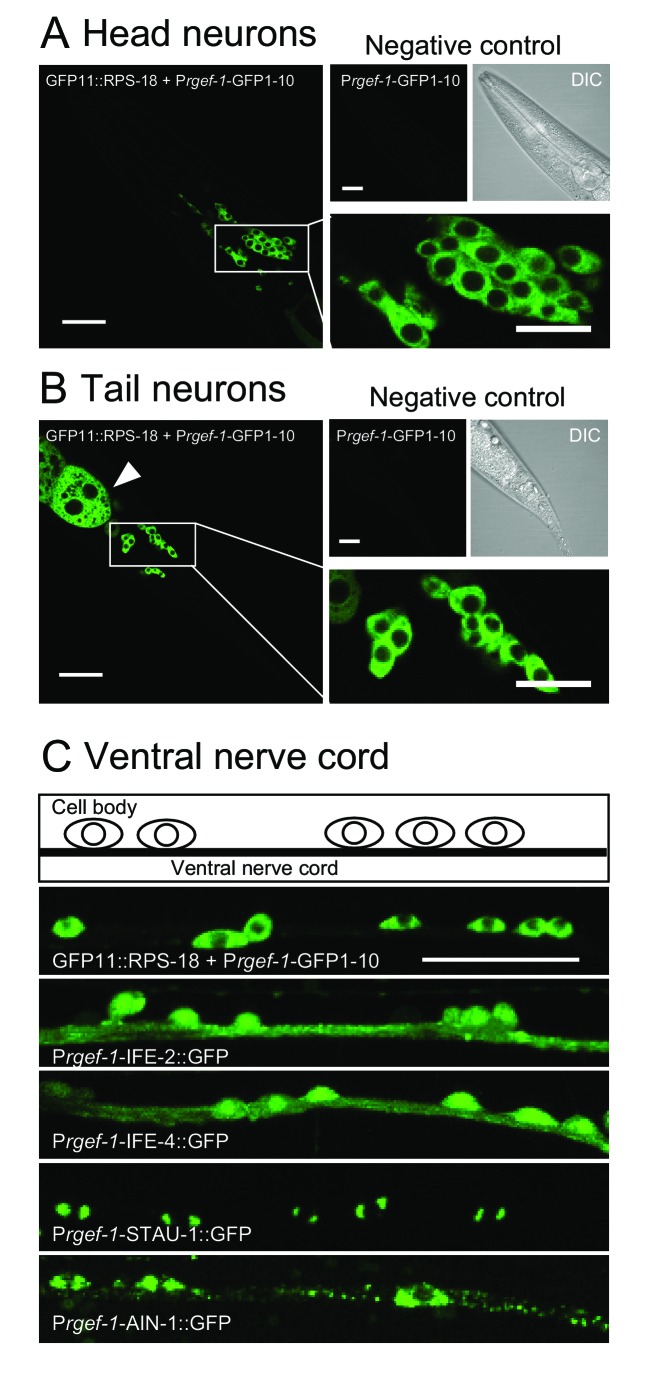
Ribosomes are mostly restricted in the neuronal soma.(A and B) Pan-neuronal Prgef-1-RIBOS visualizing ribosomes (juSi94[GFP11::rps-18]; rps-18(0) juIs409[Prgef-1-GFP1-10]) in head neurons (A) and tail neurons (B). Negative controls only expressed GFP1-10 (juIs409[Prgef-1-GFP1-10]). An arrowhead in (B) indicates ribosomes in the intestine due to the leak expression of GFP1-10. Scale bars: 20 µm; 10 µm in the magnified images. (C) Fluorescent images and a schematic of motor neurons in the ventral nerve cord. Prgef-1-RIBOS is shown in the upper left panel. Initiation factors (IFE-2::GFP and IFE-4::GFP) and putative components of RNA granules (AIN-1::GFP and STAU-1::GFP) were expressed under the control of the rgef-1 promoter using extrachromosomal arrays (see Supplementary file 2 for the transgenes). Scale bar: 20 µm.